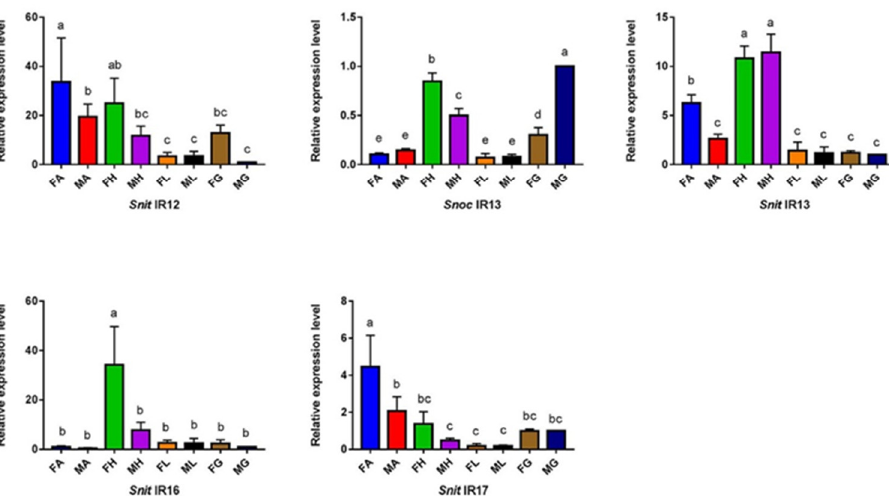
Figure 7. Relative expression levels of S. noctilio and S. nitobei IRs in different tissues of female and male adults by qPCR. FA: female antennae; MA: male antennae; FH: female head; MH: male head; FL: female legs; ML: male legs; FG: female genitals; MG: male genitals. The standard error was represented by the bar and the significant differences ( p < 0.05) were indicated by different small letters (a–f) above each bar. N/A indicates that the transcript level is too low to measure.